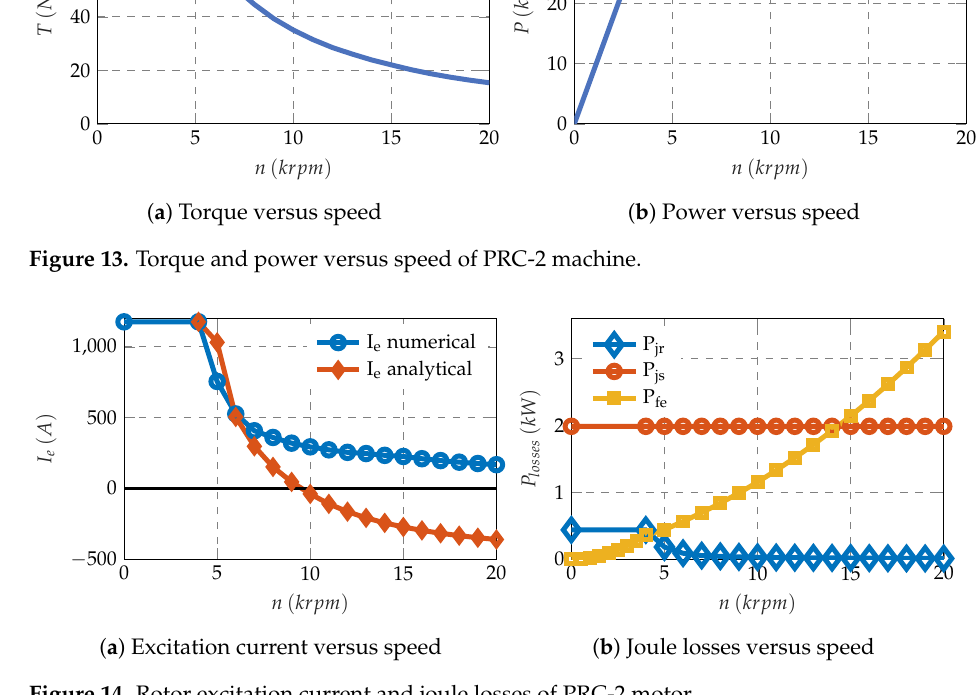
Figure 14. Rotor excitation current and joule losses of PRC-2 motor.